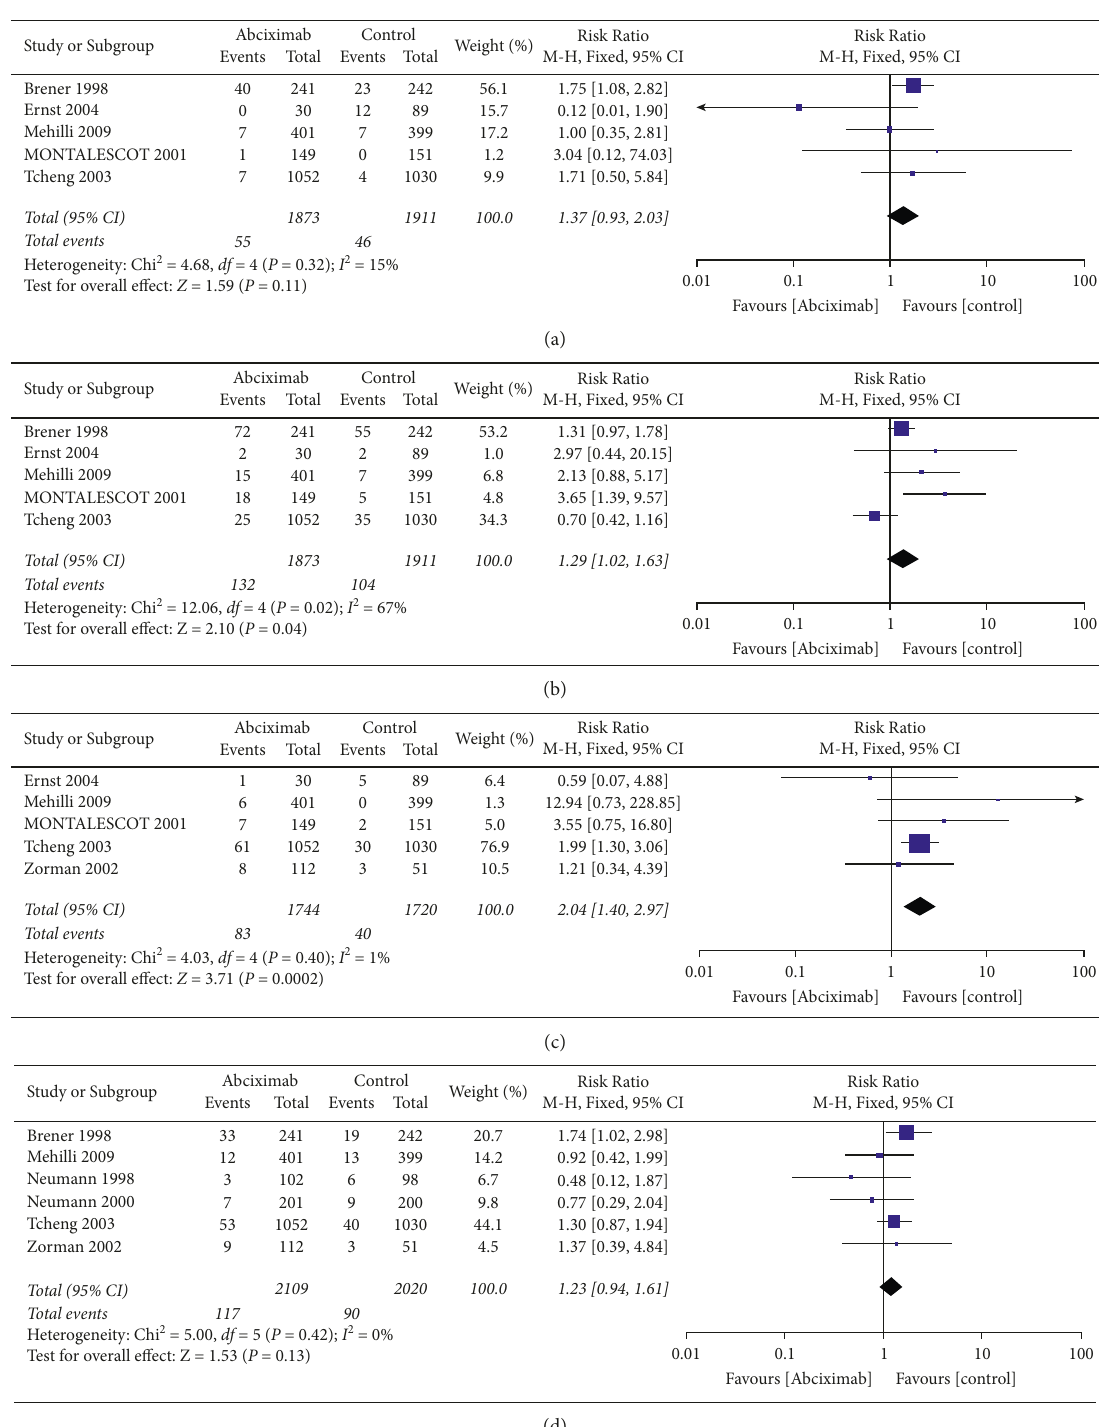
Figure 3: Comparison of primary safety outcomes between the abciximab and control groups. (a) Major bleeding, (b) minor bleeding, (c) thrombocytopenia, and (d)